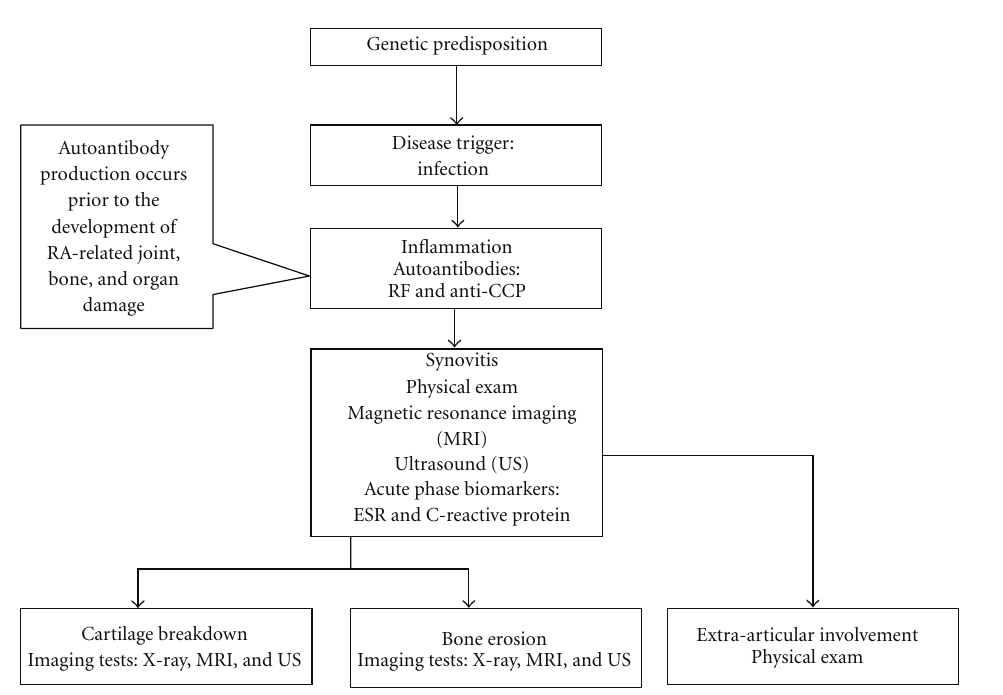
Figure 1: Pathogenesis in rheumatoid arthritis and current diagnostic tools in